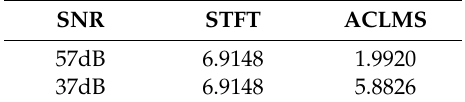
Table 1. The value of RMSE of STFT and ACLMS under different SNR conditions.